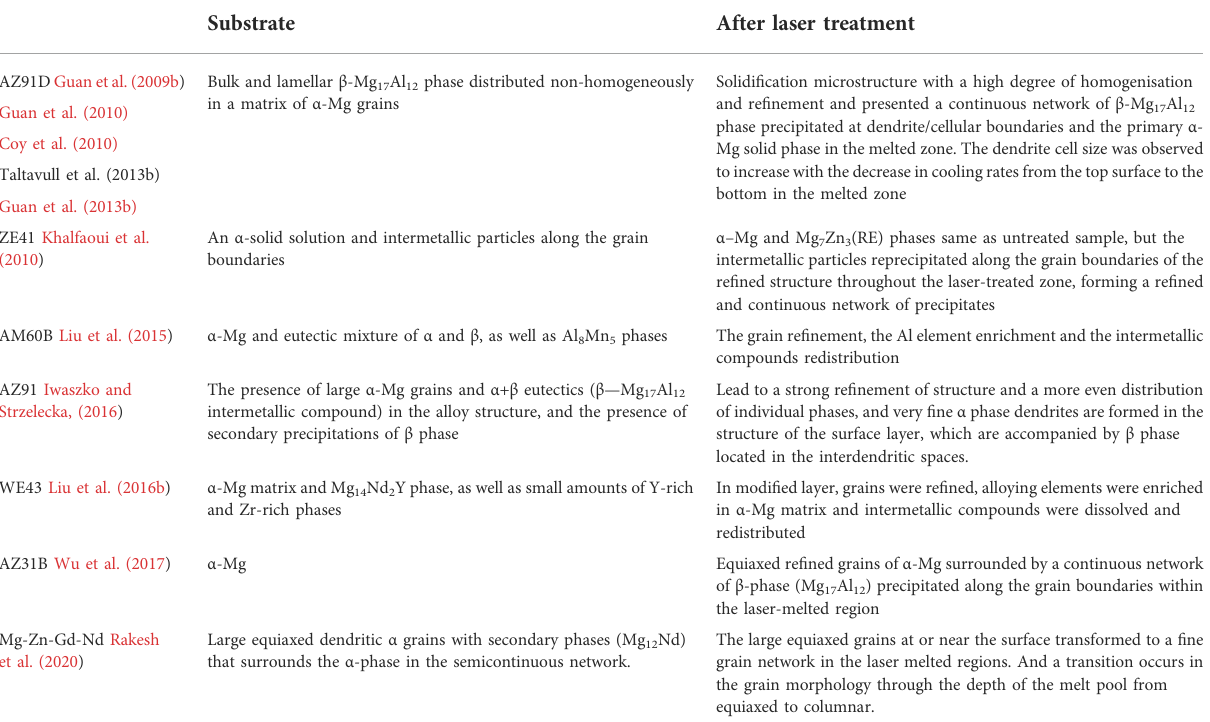
TABLE 1 Effect of laser surface treatment on the microstructure of Mg